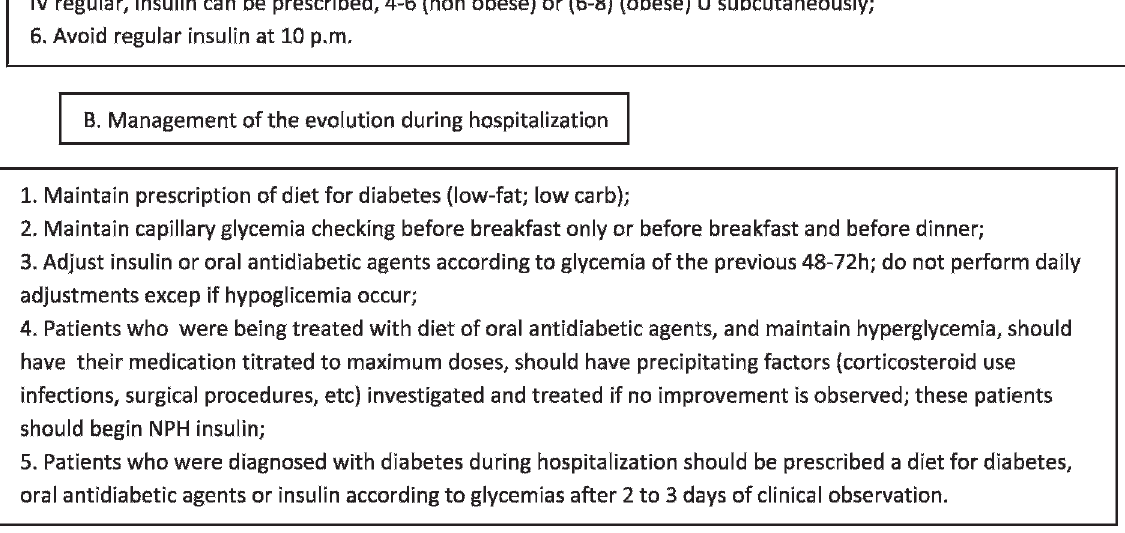
Figure 1 - The diabetes management protocol. NPO: from Latin, Nil per os , which means nothing through the